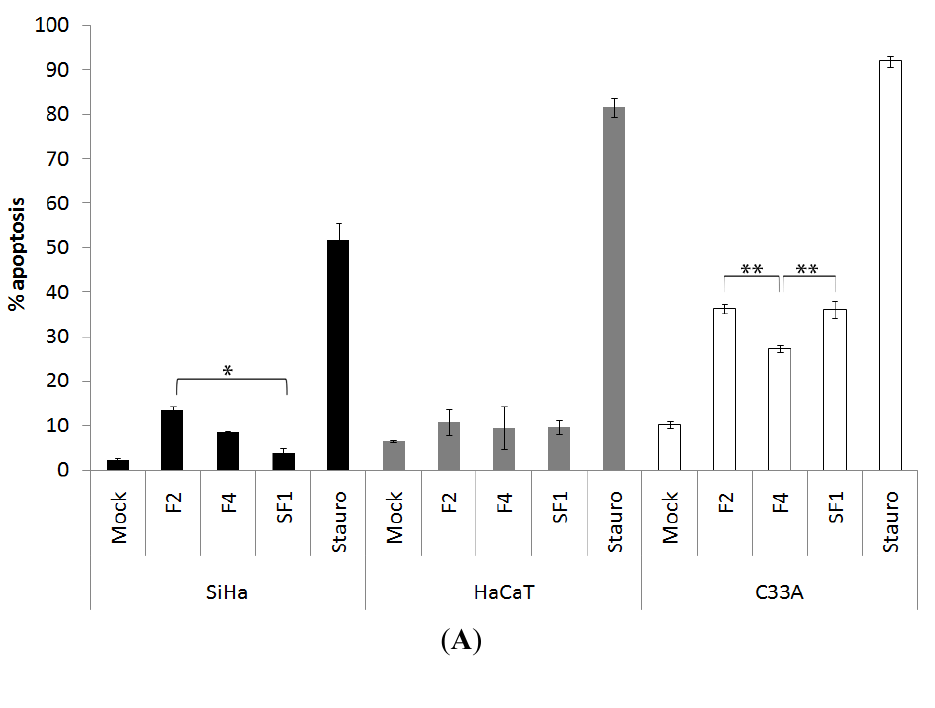
Induction of apoptosis by aptamer treatment of HPV16-